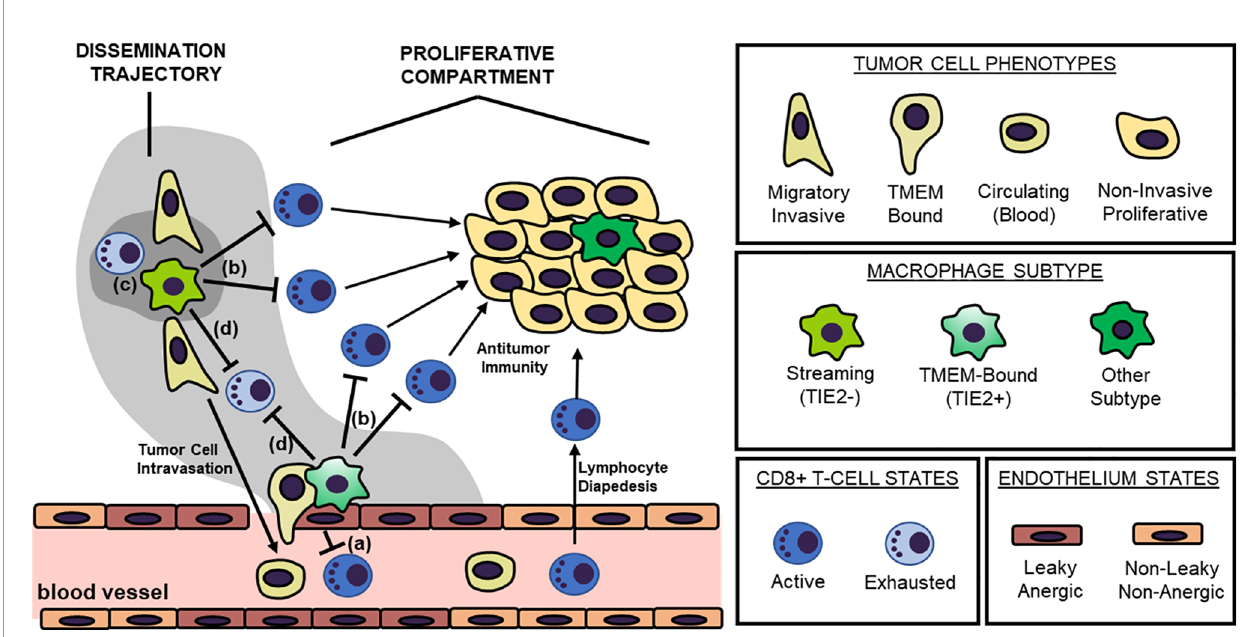
FIGURE 1 | The “ Dissemination Trajectory ” Working Model of Metastatic Dissemination. Two major cellular prerequisites are necessary for cancer cell dissemination: a TMEM doorway and a highly invasive, highly migratory cancer cell subsets streaming toward TMEM doorways. TMEM doorways are composed of three cell types, a TIE2 + macrophage, an endothelial cell and a tumor cell forming an invadopod in the vasculature, and signaling conversation among these three cells results in localized vascular opening to facilitate transendothelial migration of the highly invasive, highly migratory cancer cell subset. The highly invasive and migratory cancer cell subsets participate in a reciprocal paracrine and juxtacrine signaling loop with intratumoral macrophages that do not express TIE2, resulting in the increased induction of the actin-regulatory protein MENA INV . Eventually, these interactions result in the so called “ streaming migration ” , which is directed toward TMEM doorways, and MENA INV -facilitated transendothelial migration and metastatic dissemination. TMEM doorways and their streaming MENA INV+ cancer cell subsets are herewith referred to as “ dissemination trajectories ” . These specialized microenvironments are distinguishable from other tumor compartments with rapidly dividing tumor cells that do not share similar molecular pathways, here described as “ proliferative compartments ” . Four layers of immunosuppressive mechanisms dominate within the dissemination trajectories, that result in the development of immune deserts further facilitating the process of metastatic dissemination. These mechanisms postulate that: (a) the TMEM endothelium is anergic, thus not allowing for T cell diapedesis; (b) dissemination trajectories do not support cytokine/chemokine matching for allowing T cell chemotaxis; (c) dissemination trajectories have a unique metabolic landscape that is refractory for T cell chemotaxis and/or function; and fi nally (d) dissemination trajectories are characterized by the induction of immune checkpoint signaling, that promoted exhaustion of T cells. Overall, tumor-associated macrophages (TAMs) within these dissemination trajectories play the pivotal role in regulating all four layers of immunosuppression, although secondary mechanisms have also been identi fi